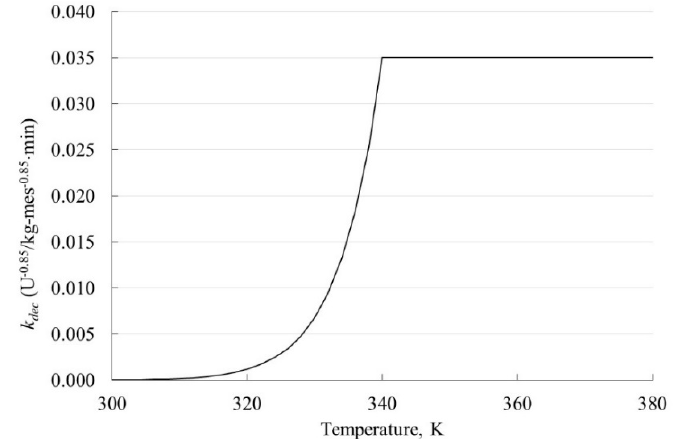
Figure 8. Relation between reaction rate constant, k dec , and temperature.